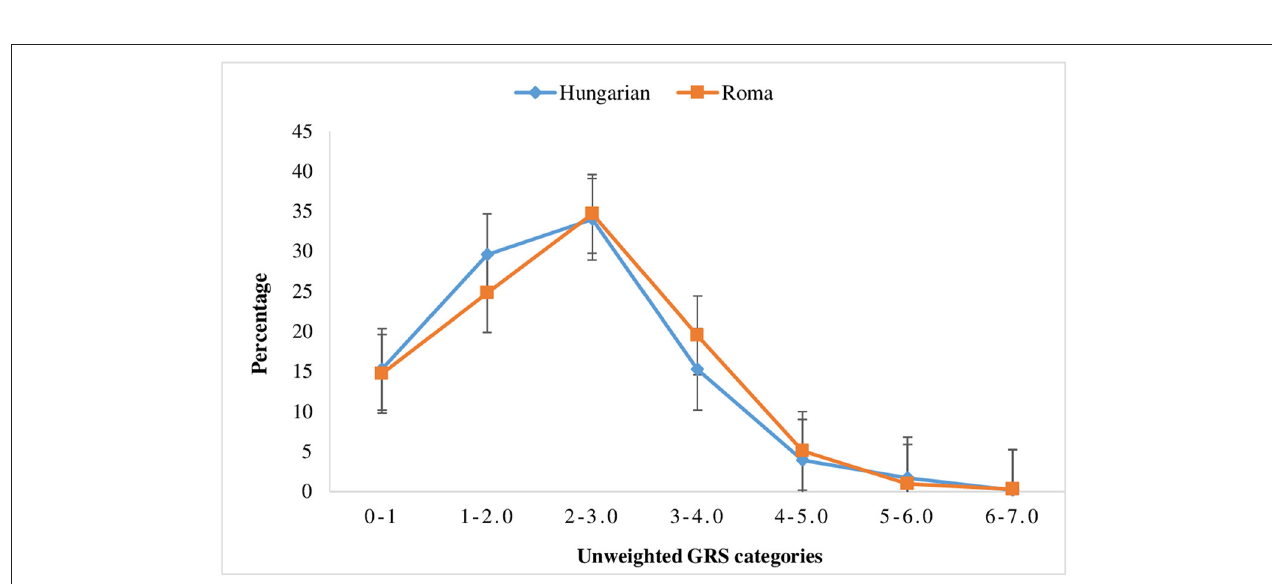
FIGURE 2 | Distribution of un-weighted genetics risk scores in the general Hungarian and Roma population (the error bars indicate the standard error of the mean).